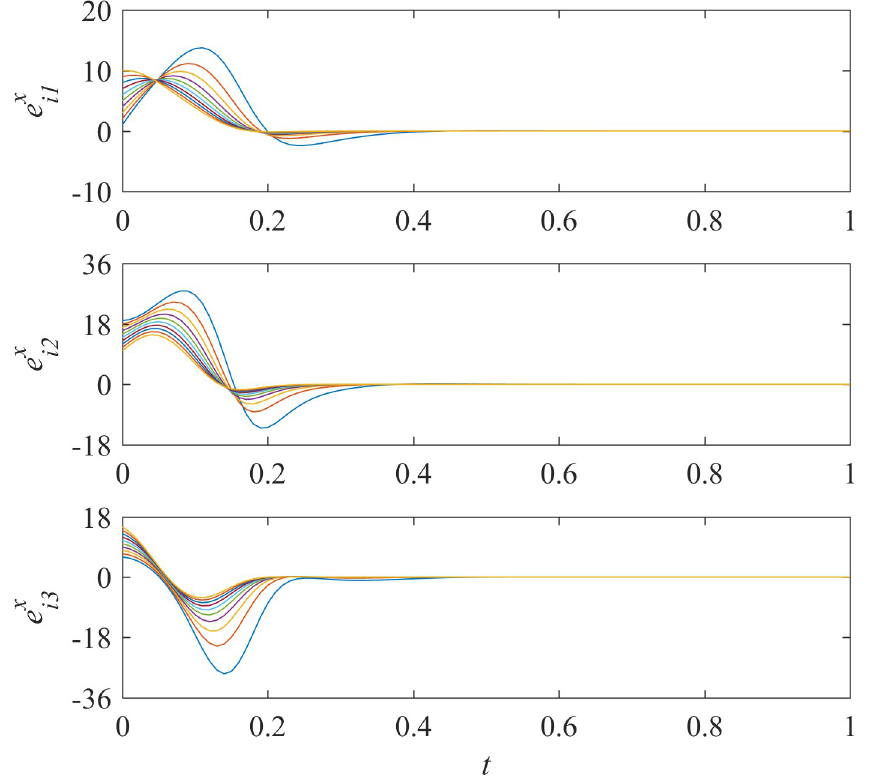
Fig 1. States of error system between the nodes and the isolate node in sub-network X (Eq (3)).